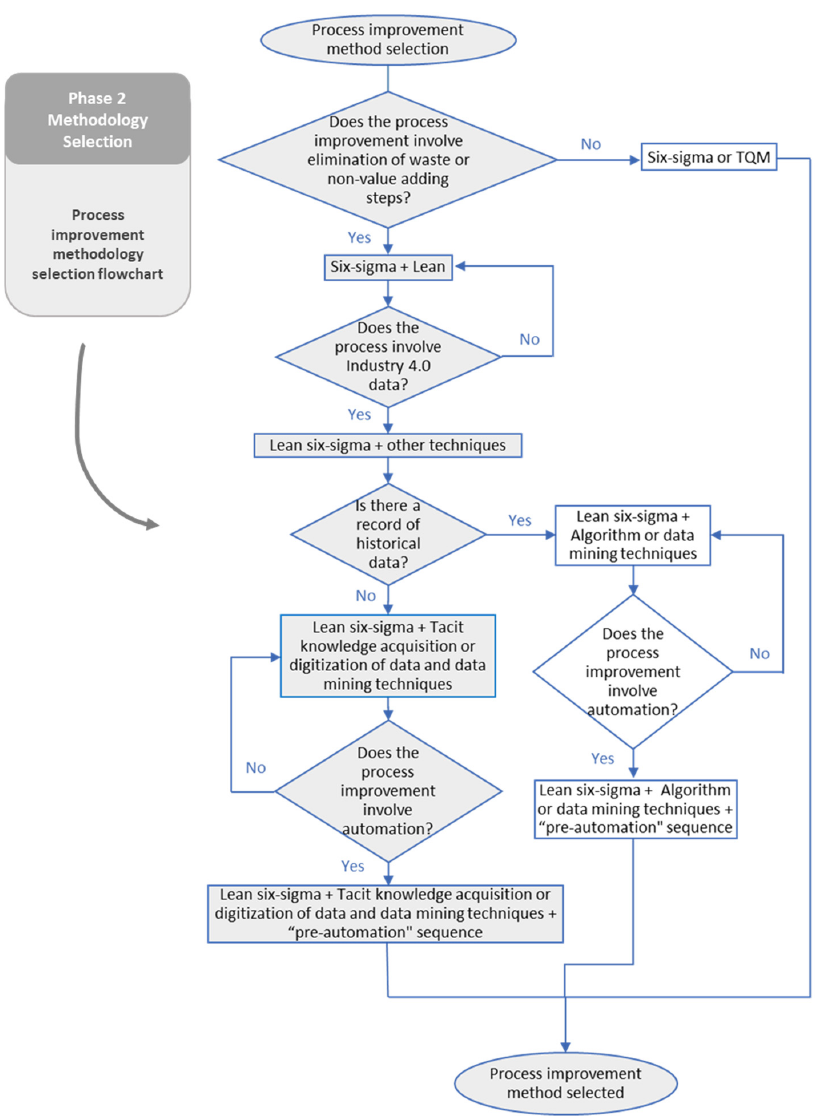
Figure 11. Combined methodology—Phase 2.